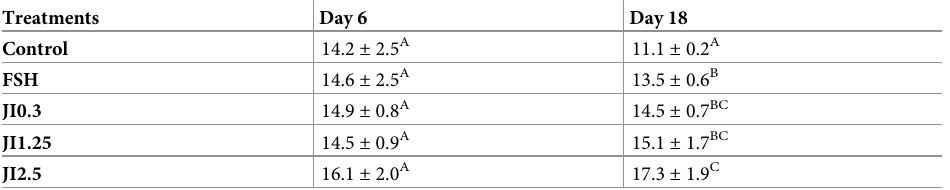
Table 5. Level of ROS measured in the culture medium from secondary follicles before (D0) and during 18 days of in vitro culture (D6, D12, D18) in MEM + (Control), FSH or in JI0.3, JI1.25 or JI2.5.